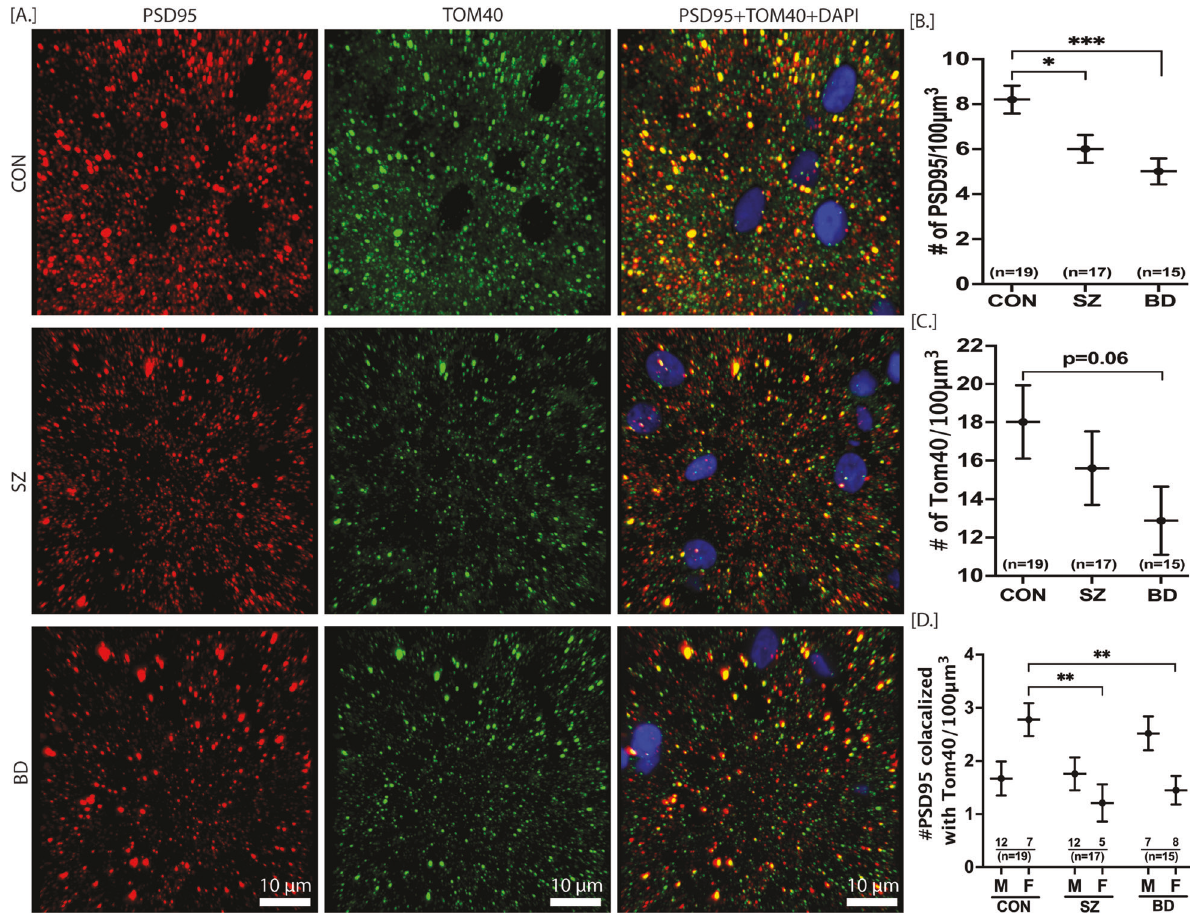
Fig. 5 Overall mitochondria number, synapse number and synaptic mitochondria number in DLPFC of CON, SZ and BD subjects. The representative images for PSD95, TOM40 and PSD95 colocalized with TOM40 are depicted in ( A ). A repeated measure analysis was performed for statistical signi fi cance with adjustment of age and sex. The number of PSD95 was signi fi cantly lower in both SZ and BD compared to CON group ( B ). The overall number of TOM40 was not signi fi cantly different in SZ and BD compared to CON, although there was a decrease trend in BD ( C ). The sex x group effect was signi fi cant for the PSD95 colocalized with TOM40. Both the female SZ and female BD subjects had signi fi cantly lower PSD95 colocalized with TOM40 compared to CON females [ D ]. All data are represented as least square mean (LSM) ± Std. error. p < 0.05, p < 0.01 and p < 0.001 are denoted by *, ** and ***, respectively, otherwise p > 0.05. CON = control ( n = 19), SZ = schizophrenia ( n = 17), BD = bipolar disorder ( n = 15), Red spots = PSD95, green spots = TOM40, yellow spots = PSD95 colocalized with TOM40, blue = DAPI nuclear had signi fi cantly higher ( p = 0.013) synaptic mitochondria regions studied here, the DLPFC has been the most affected area compared to the male CON group (Table ST6). Both the female in terms of mtDNA CN, mtDNA deletions, and complex I activity. SZ ( p = 0.002) and female BD ( p = 0.003) groups had signi fi cantly Therefore, we investigated any change in overall mitochondria lower synaptic mitochondria compared to the female CON group number, synapse number, and synaptic mitochondria number in (Table ST6). The male subjects in the SZ and BD groups did not DLPFC of SZ and BD subjects. The overall number of differ from male CON subjects for synaptic colocalized mito- mitochondria, synapse, and synaptic mitochondria was deter- chondria ( p = 0.85, p = 0.09, respectively) (Fig. 5C – E) (Table ST6). mined through immunostaining of mitochondria surface marker The age did not signi fi cantly affect the number of PSD95, TOM40, synaptic marker PSD95, and colocalization of TOM40, and colocalized PSD95 with TOM40 (Table ST13). TOM40 + PSD95, respectively. The mixed model analysis was Similarly, the number of PSD95, TOM40, and colocalized PSD95 conducted with adjustment of subjects ’ age, pH, and sex. For the with TOM40 was not dependent on medications present at the overall synapse number (# of PSD95 puncta), the main effect of time of death (Table ST14). the diagnosis group was signi fi cant. The synaptic number marker (number of PSD95) was signi fi cantly lower in the DLPFC of both SZ and BD ( p = 0.0008) subjects compared to control subjects DISCUSSION (Fig. 5B). There was no signi fi cant main effect of group for overall Regional alteration of mtDNA copy number in SZ and BD mitochondria number (# of TOM40). TOM40 was not signi fi cantly Subjects with schizophrenia showed increased mtDNA CN in different in SZ ( p = 0.388) and BD ( p = 0.065) groups compared DLPFC with no alterations of mtDNA CN in STG, V1, and NAc to the CON group. For the synaptic mitochondria number regions. On the other hand, bipolar patients showed increased (colocalized TOM40 with PSD95), the main effect of the group mtDNA CN in DLPFC, decreased mtDNA CN in STG, and was not signi fi cant. However, very interestingly, the sex x group unaltered mtDNA CN in V1 and NAc (Fig. 1). These mtDNA CN interaction was statistically signi fi cant. The female CON group